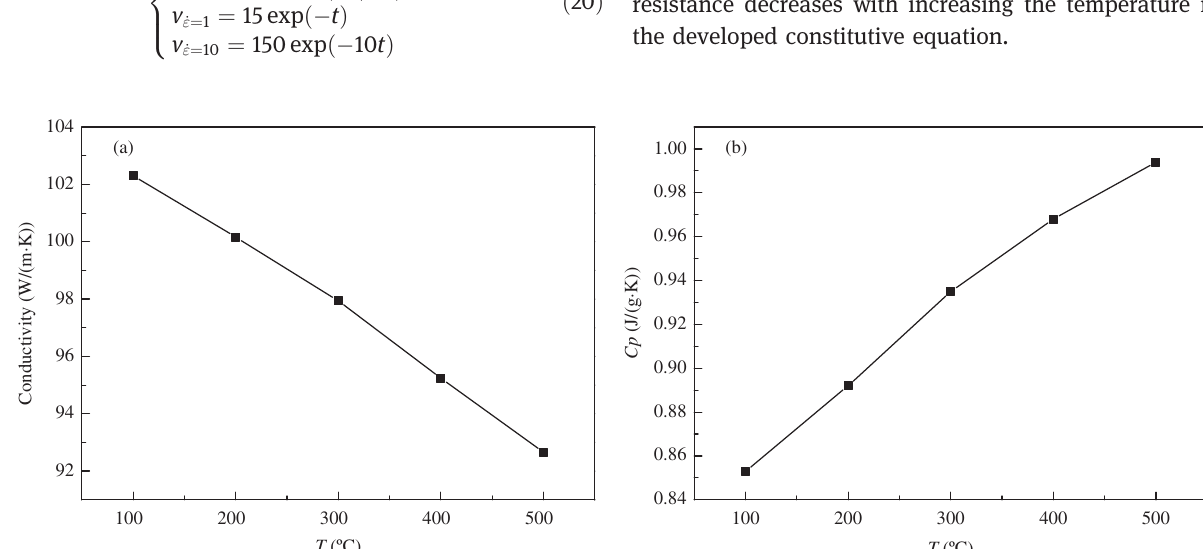
Figure 4: The thermal conductivity and specific heat capacity of 3104 alloy: (a) the thermal conductivity and (b) specific heat capacity.